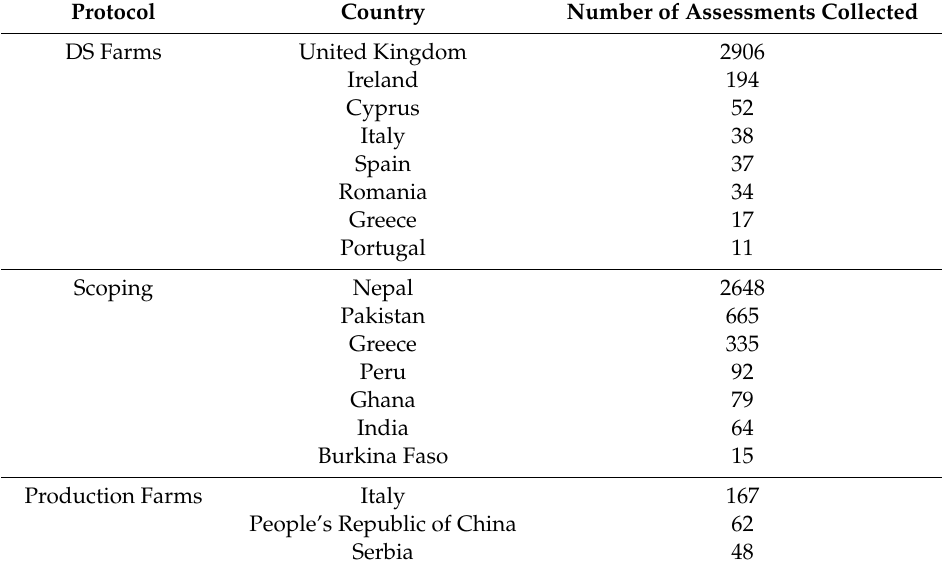
Table 5. Number of assessments collected using each of the three protocols, presented in descending order by